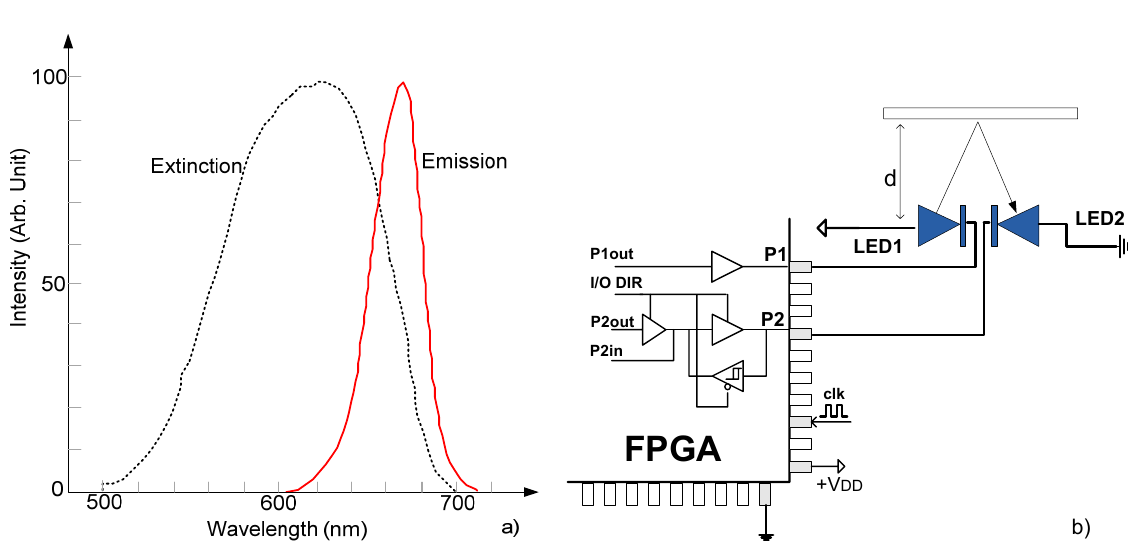
Figure 1. ( a ) Spectral characteristic of LED in emission and extinction (detecting) mode [4]. ( b ) FPGA-based LED-LED distance